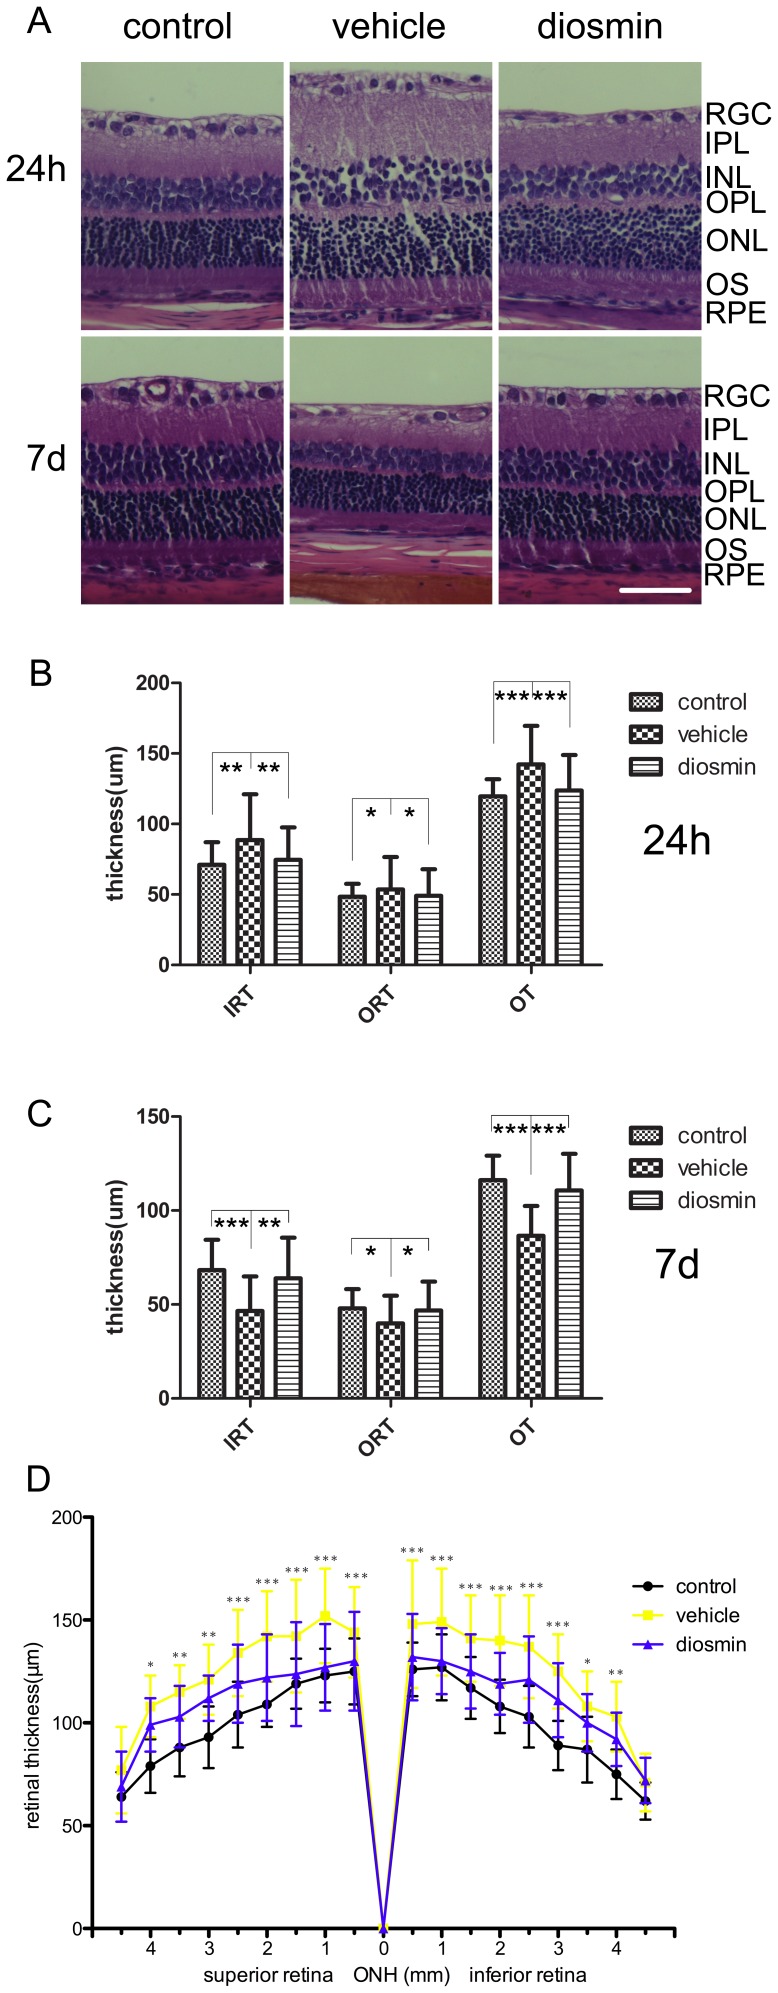
Histological examination after retinal ischemia.The retinal I/R injury induced retinal edema and retinal atrophy 24 h and 7 d after ischemia, respectively. These insults were reversed by diosmin, as shown in the HE analysis. (A) Representative photographs of rat retinas from the three groups 24 h and 7 d after ischemia. The thickness of the retinas was analyzed quantitatively (B) 24 h and (C) 7 d after ischemia. (D) Changes of the whole retinal thickness 24 h after retinal ischemia for three groups. RGC, retinal ganglion cells; IPL, inner plexiform layer; INL, inner nuclear layer; OPL, outer plexiform layer; ONL, outer nuclear layer; OS, outer segment; RPE, retinal pigment epithelium; IRT, inner retinal thickness; ORT, outer retinal thickness, OT, overall thickness, ONH, optic nerve head. Data are expressed as the mean±SD (n = 6). *P<0.05, **P<0.01, ***P<0.001. Scale bar, 50 µm.